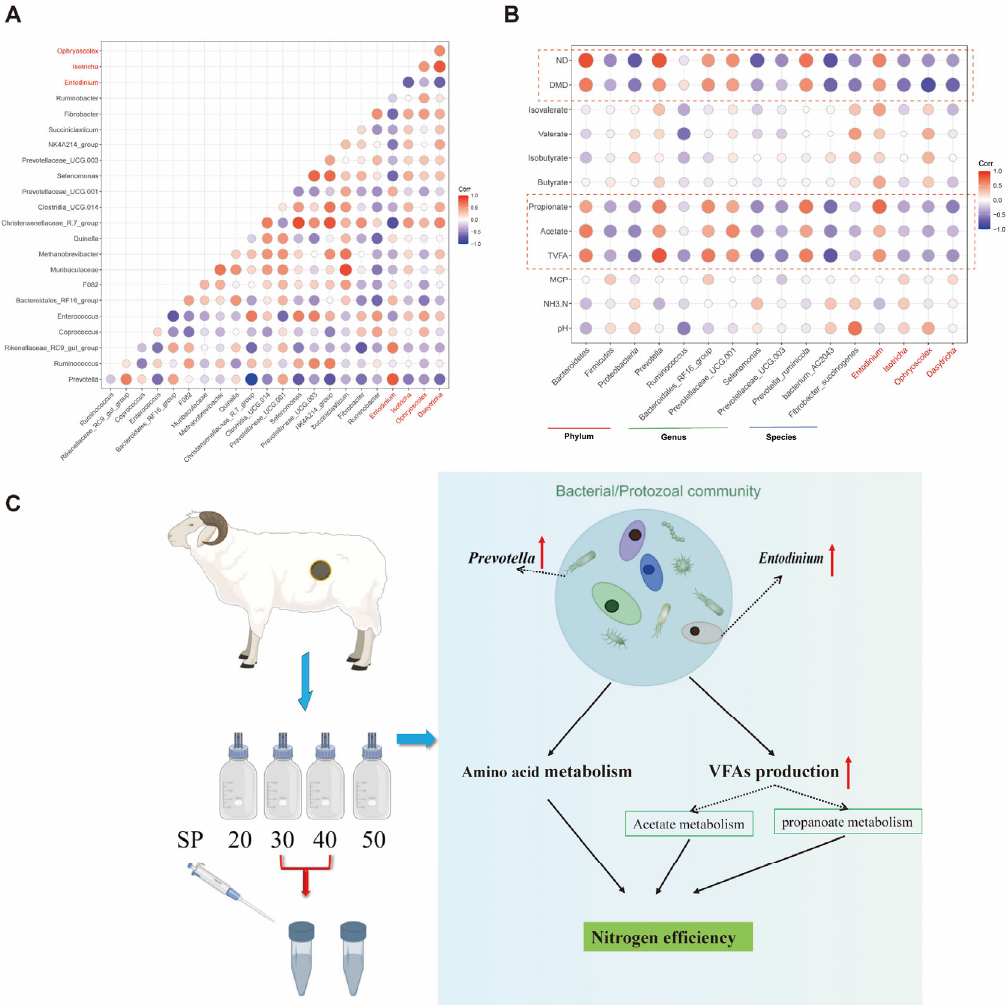
Figure 5. The interaction of rumen bacteria, protozoa and fermentation. ( A ) Spearman’s rank correlations between rumen bacteria and protozoa at the genus level. ( B ) Spearman’s correlations between rumen microbiota and fermentation. Based on the color key on the right, the degree of each correlation is displayed in the shade of the color; the blue circle represents negative correlations, and the red circle represents positive correlations. The red fonts represent the protozoa genus. ( C ) Integrative diagram showing the regulatory role of bacteria–protozoa interactions in rumen nitrogen metabolism as SP (% of CP) set as 30 or 40 in